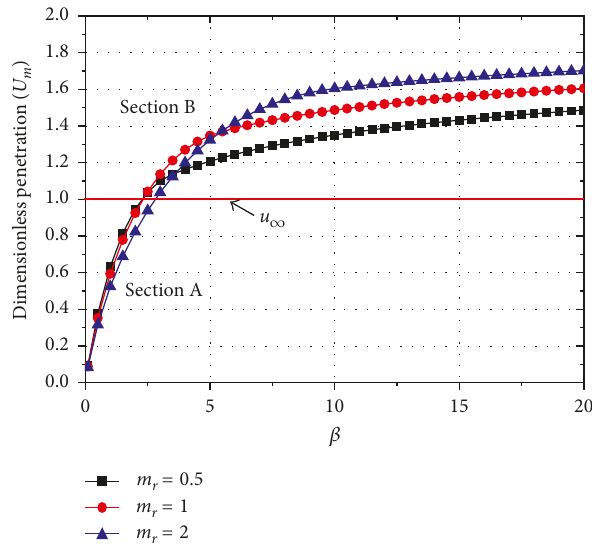
Figure 6: State of reaching drill bit dimensionless penetration U with respect to mass ratio, m r , and β